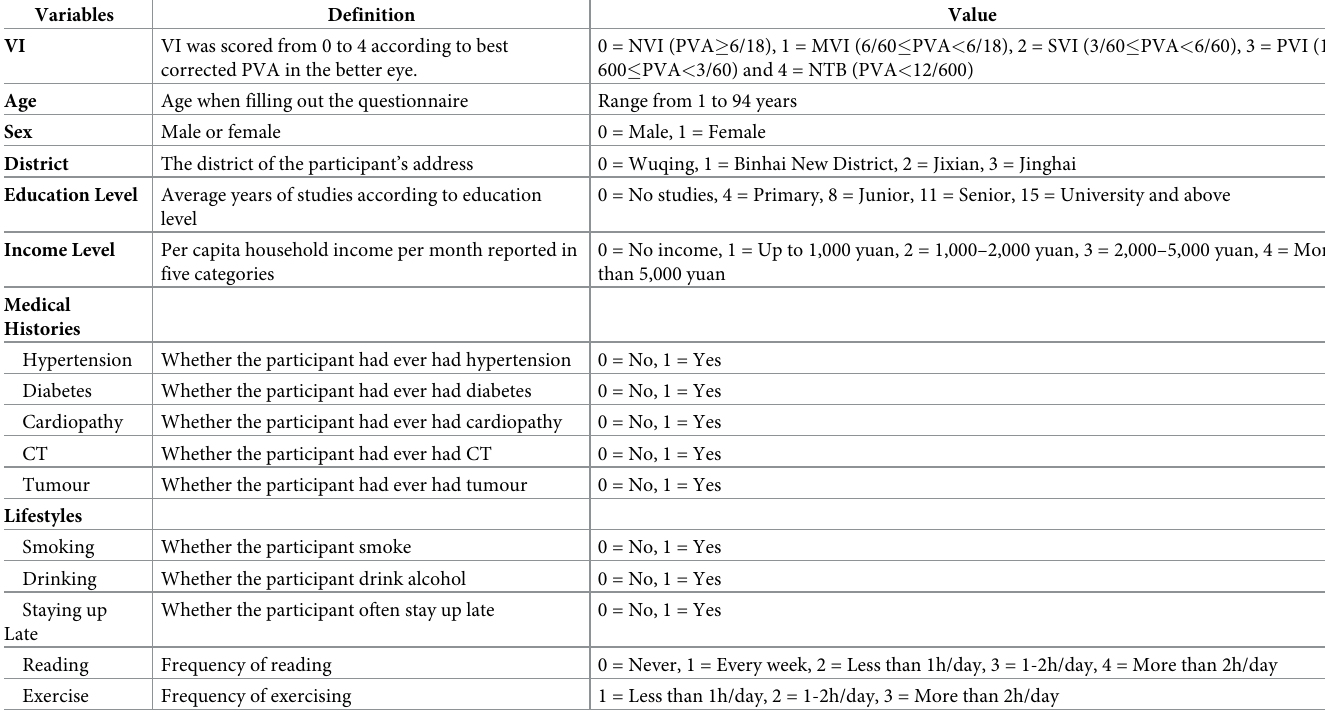
Table 1. Definitions and values of